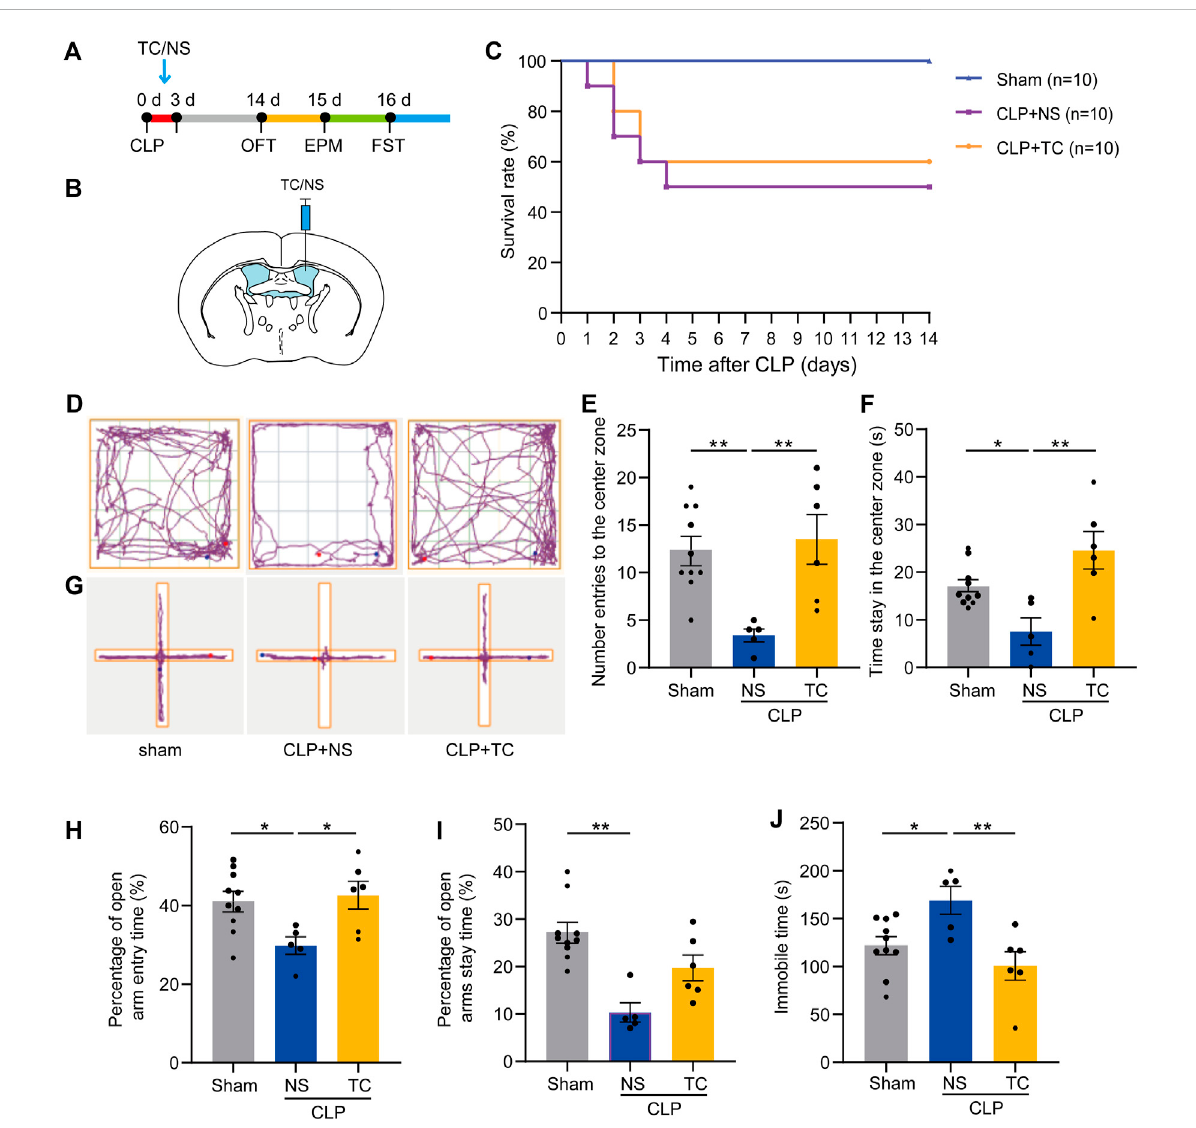
FIGURE 7 TAT-CIRPalleviateddepression-likebehaviorsinmicewithsepsis. (A) .AnoutlineoftheexperimentalprocedureforTCinjectionandbehavioral tests of mice with sepsis. (B) . Schematic con fi guration of icv injection. (C) . Survival curve for TC icv injection. 5of 10 mice in the CLP + NS group and 6 of 10 mice in the CLP + TC group survived by day 14. (D) . The representative tracking chart of the OFT. (E) . The effects of different treatments on number of entries to the center zone. (F) . The time spent in the center zone in the OFT (n sham = 9, n CLP + NS = 6, n CLP + TC = 6). * p < 0.05, ** p < 0.01. Data are shown as the mean ± SEM. (G) . The representative tracking chart of the EPM. (H) . In the EPM, percentage of entries to the open arms. (I) . The percentage of time spent in the open arms (n sham = 9, n CLP + NS = 6, n CLP + TC = 6). * p < 0.05, ** p < 0.01. Data are shown as the mean ± SEM. (J) . Total immobility time over 5 min in the FST among different groups (n sham = 9, n CLP + NS = 6, n CLP + TC = 6). * p < 0.05, ** p < 0.01. Data are shown as the mean ±